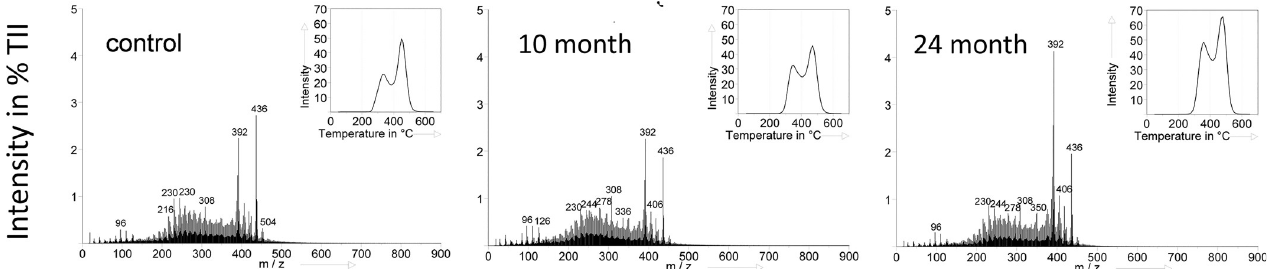
Fig 1. Thermograms of total ion intensity (%TII) (upper right) and summed averaged pyrolysis-field mass spectra of samples for the microaggregate size fraction of the control without clear-cut, 10, and 24 month after clear-cut.